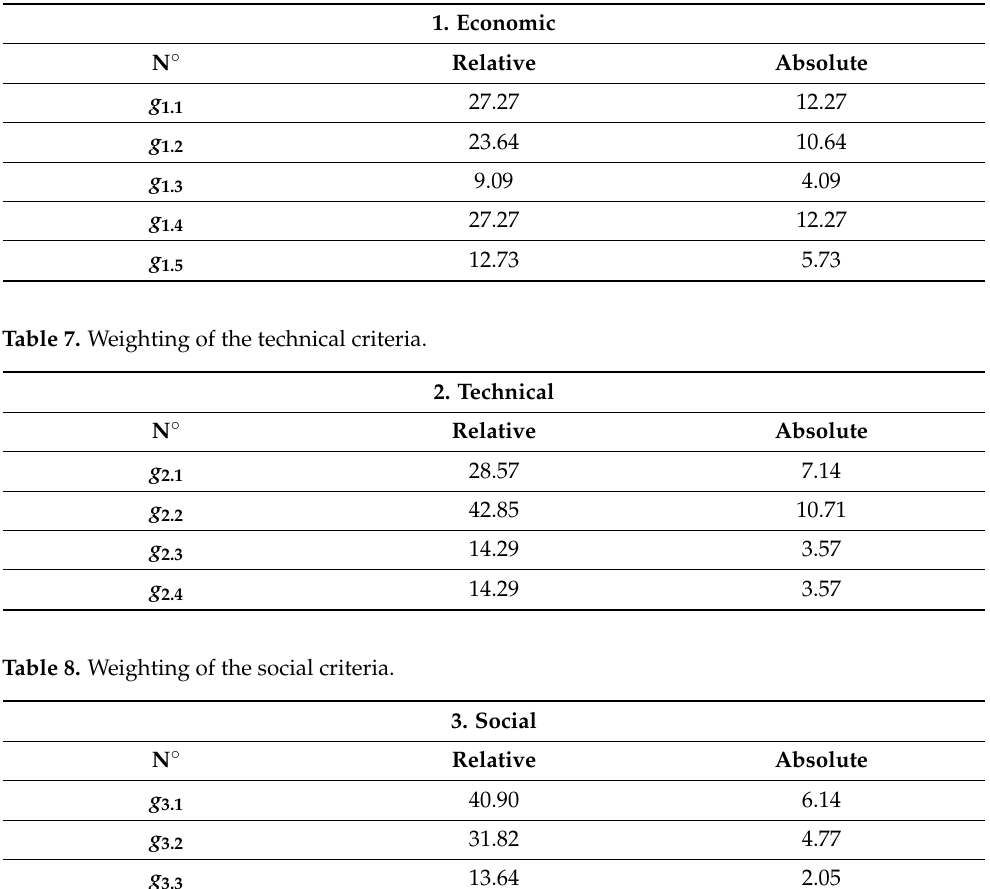
Table 6. Weighting of the economic criteria.